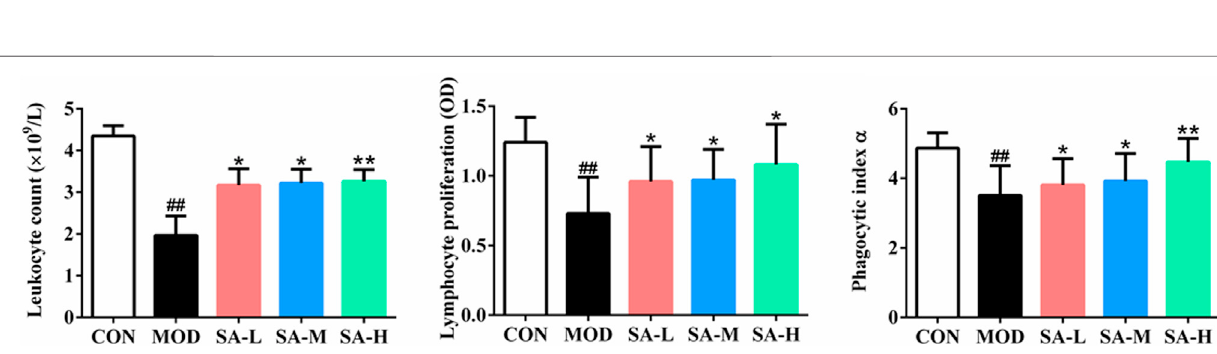
FIGURE 5 | Effects of SA on the serum TNF- α , IFN- γ , IL-1 β and IL-2 levels and the organ indexes. Notes: Groups: CON, control group; MOD, model group; SA-L, Schisandrol A low-dose group; SA-M, Schisandrol A medium-dose group; SA-H, Schisandrol A high-dose group. All the values were expressed as mean ± standard deviation ( n (cid:1) 12). #: p < 0.05, vs . CON; ##: p < 0.01, vs. CON; *: p < 0.05, vs . MOD; **: p < 0.01, vs . MOD.